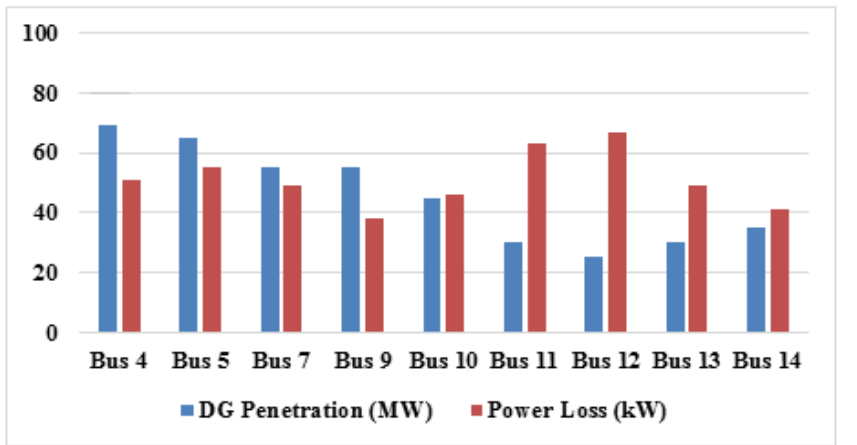
Figure 5. Validation of the proposed algorithm with bar charts for various DGs at all load buses with respective system losses for the 14-bus system of IEEE. Table 7. The load buses with appropriate DG capacity for minimum power loss at each load bus for the 14-bus system of IEEE.